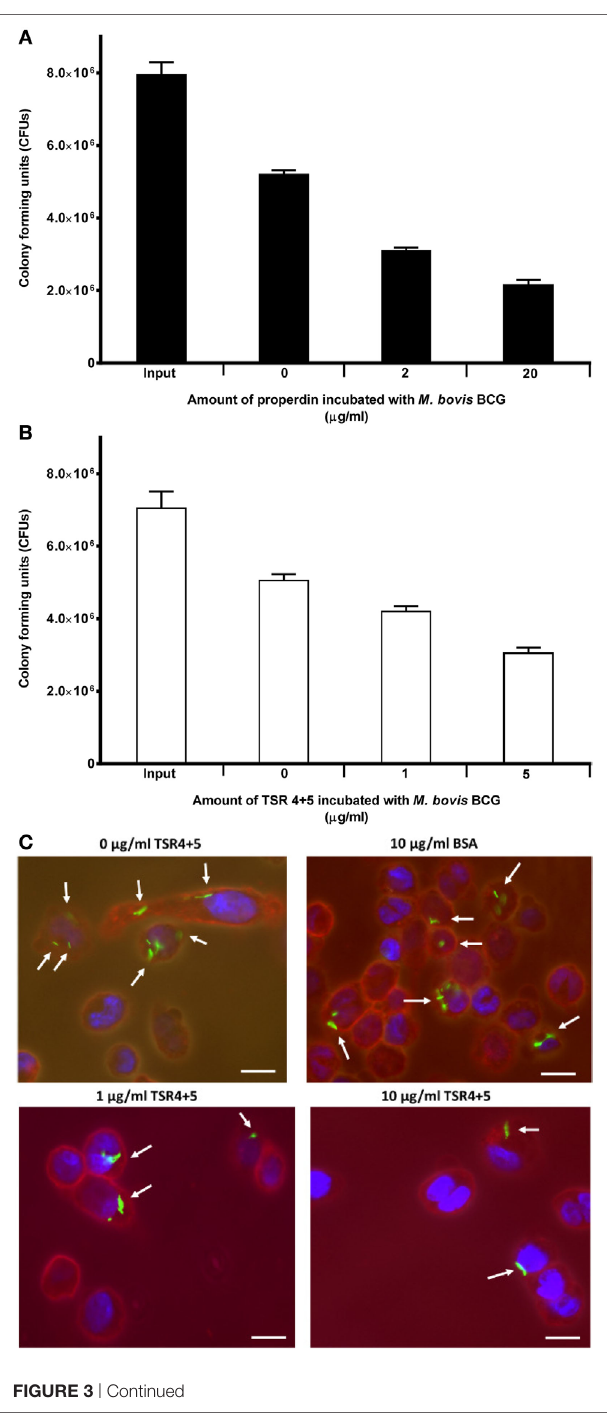
FigUre 3 | Effect of properdin and thrombospondin repeats (TSR) 4 + 5 on the phagocytosis of Mycobacterium bovis BCG by THP-1 cells. (a) M. bovis BCG was treated with properdin at concentrations of 0, 2, and 20 µg/ml or with (B) TSR4 + 5 at concentrations 0, 1, and 5 µg/ml. The mycobacteria were incubated with macrophage for 2 h. After THP-1 cell lysis, surviving internalized M. bovis BCG were measured by plating lysates on 7H10 media to obtain colony-forming units (CFUs). The input value is the starting number of M. bovis BCG added to the THP-1 cells, before phagocytosis. A one-way ANOVA test was performed on the data to determine significant differences in CFU count by properdin or TSR4 + 5. All comparisons were significant ( p < 0.05), unless where shown (ns, not significant, p > 0.05). Samples were analyzed in triplicate. (c) Differential uptake of GFP- M. bovis BCG by THP-1 macrophages after treatment with 0, 1, and 10 µg/ml of TSR4 + 5, or 10 µg/ ml of BSA, used as a negative control. Cells were incubated for 2 h. Cells were then washed, fixed, and stained with AlexaFluor546-conjugated wheat germ agglutinin to reveal the plasma membrane (red), and the nucleus was stained with DAPI (blue). Images are shown as single sections, taken using a Leica DM4000 microscope; bar scale 10